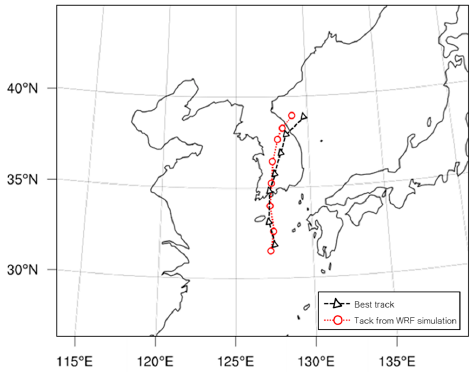
Figure 3. Comparison of the simulated track using WRF and best track of Rusa.